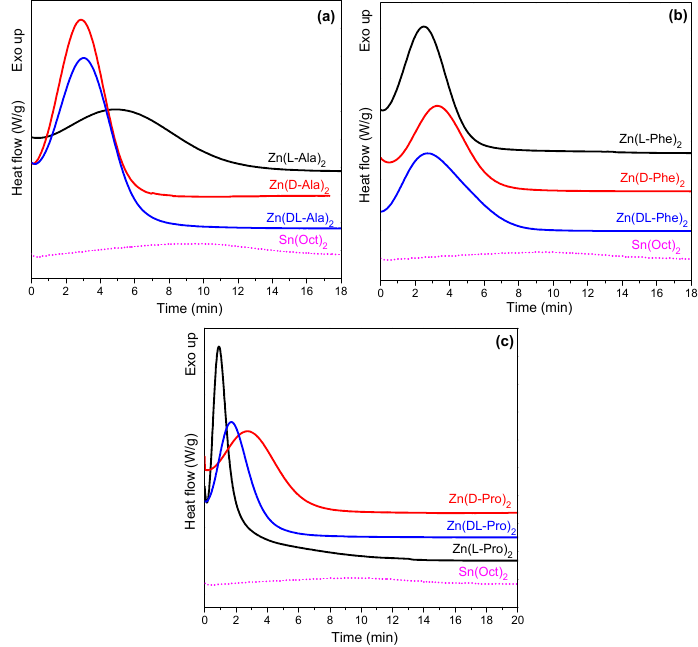
Figure 4. Isothermal crystallization exotherms at 125 °C of PLLA obtained by ( a ) Zn(Ala) 2 , ( b ) Zn(Phe) 2 , ( c ) Zn(Pro) 2 (Sn(Oct) 2 as reference).